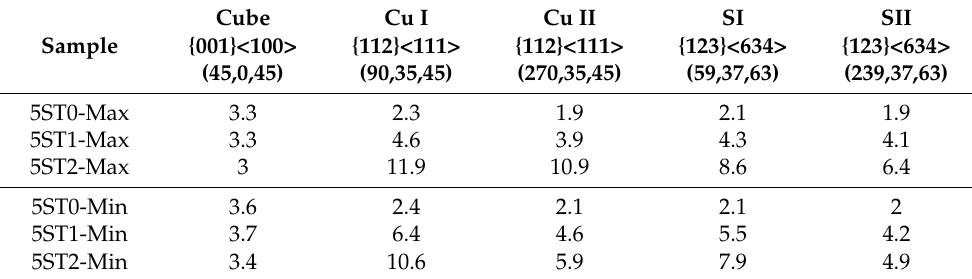
Sample Table 5. Cube, copper and S components for tube 5 (all units in mrd).